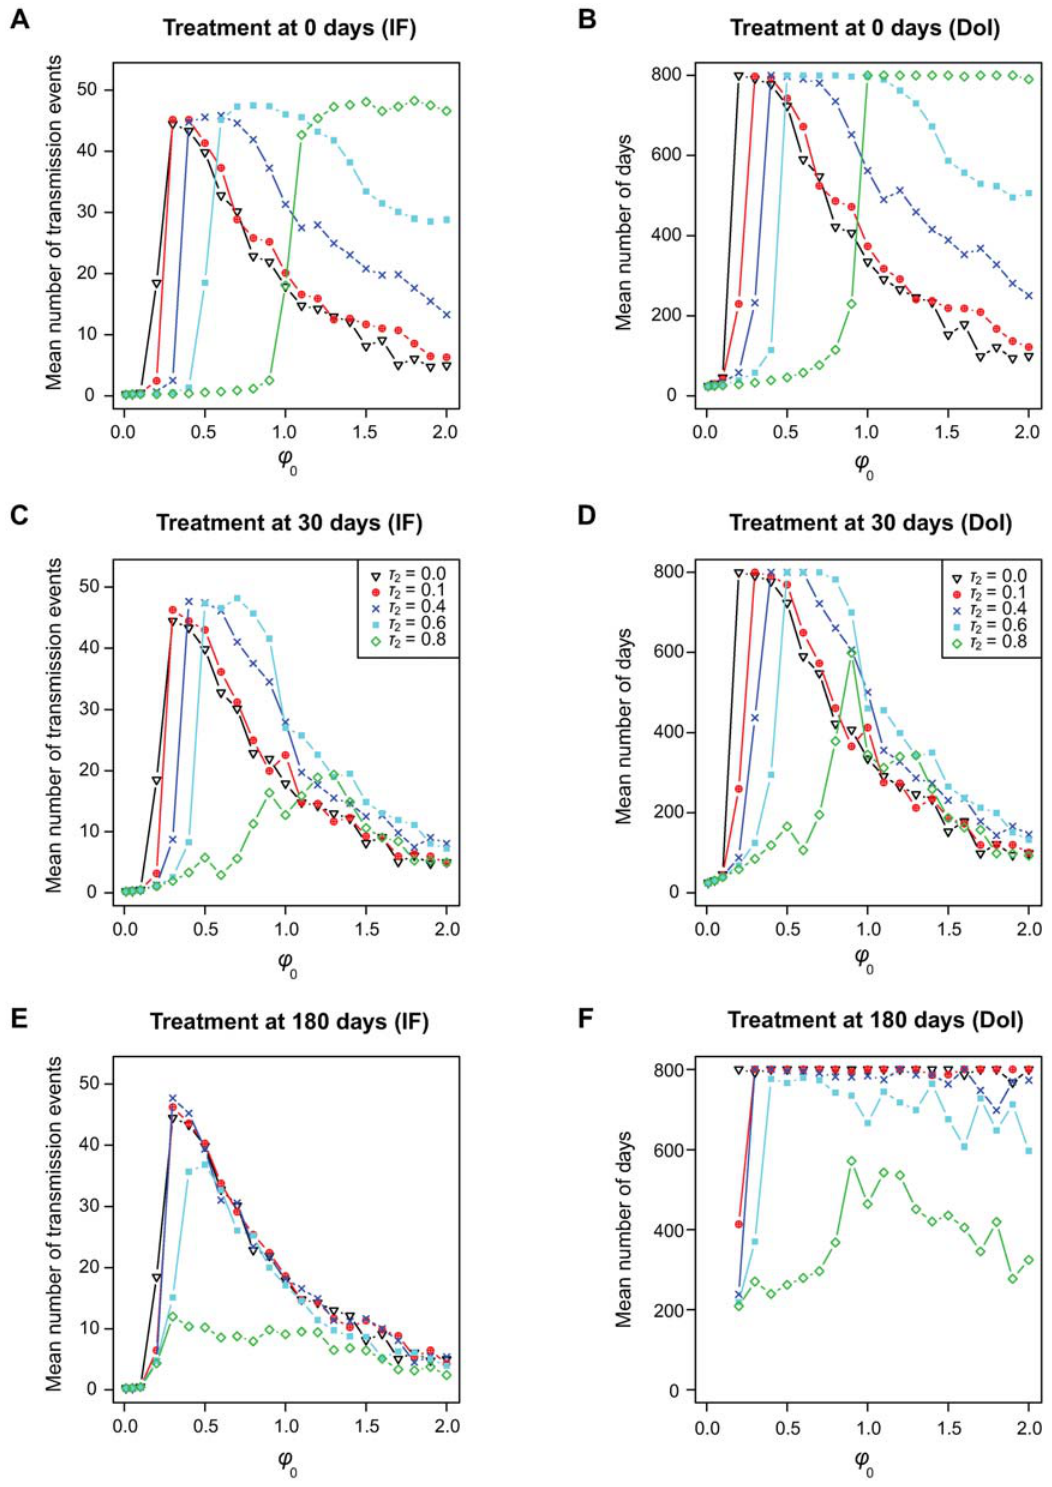
Figure 5. Effect of the timing and of the intensity of anti-viral treatments limiting viral replication. In panels A, and B the treatment starts at the time of the infection, in panels C, and D the treatment starts 30 days after the beginning of the infection. Finally in panels E and F treatment starts 180 days after the infection. Panels A, C, and E show the average infection fitness (IF). Panels B, D, and F show the average duration of the infections (DoI). The latter is calculated by excluding simulation runs that result in host before the beginning of the treatment (this is done to highlight the effect of the treatment at the within-host level). Different colours correspond to different treatment intensities ( t 2 , see legend in panels C and D). The default case is in black. Note that in panel F, infections starting with low replication rates are cleared before treatment is initiated. For further details about the simulations see the main text and the Text S1.